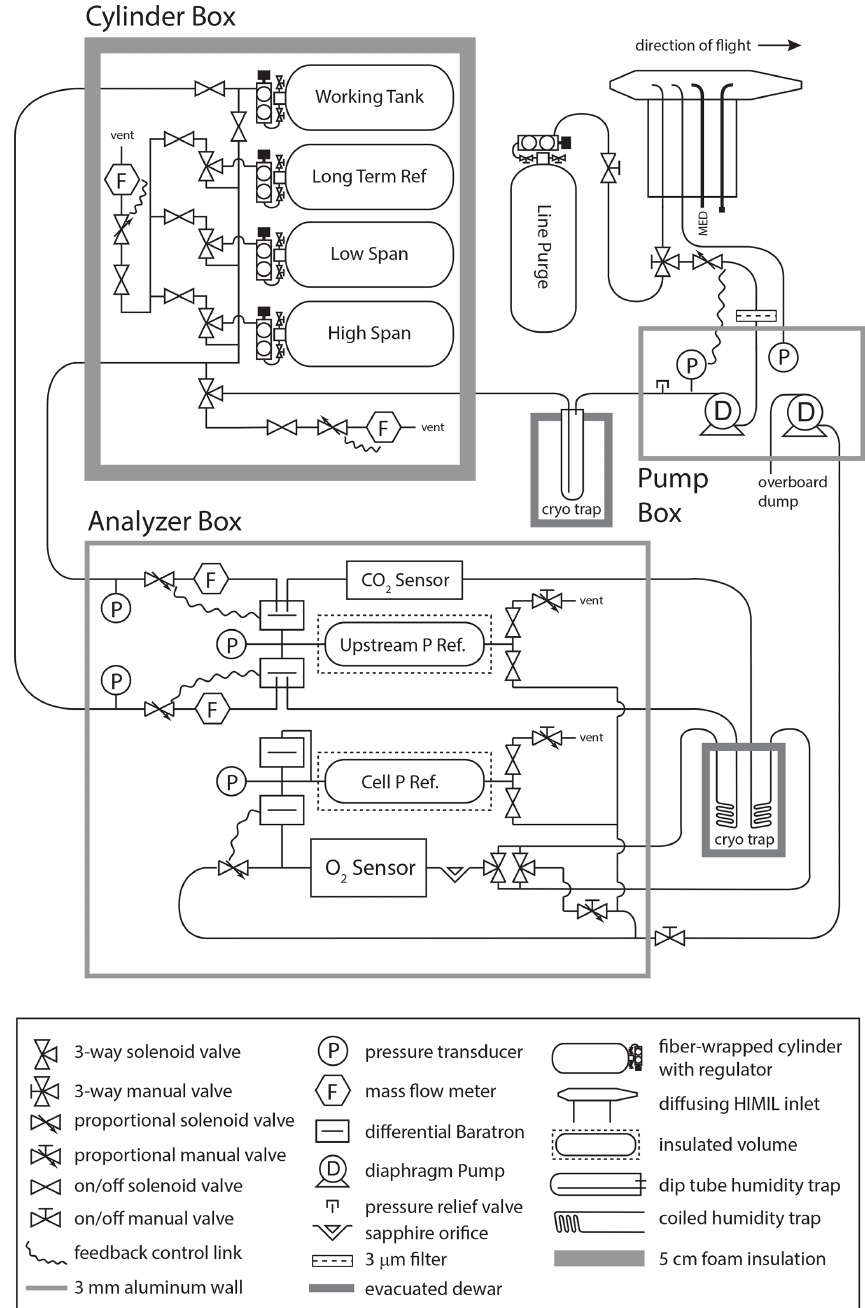
Figure 1. Plumbing diagram of the AO2 instrument. AO2 consists of an inlet, a pump box, an insulated cylinder box, an analyzer box, a single cryotrap shown here in two parts, and an external purge cylinder. See Sect. 2.1 for a description of the individual components. See Table S1 in the Supplement for selected vendor and part